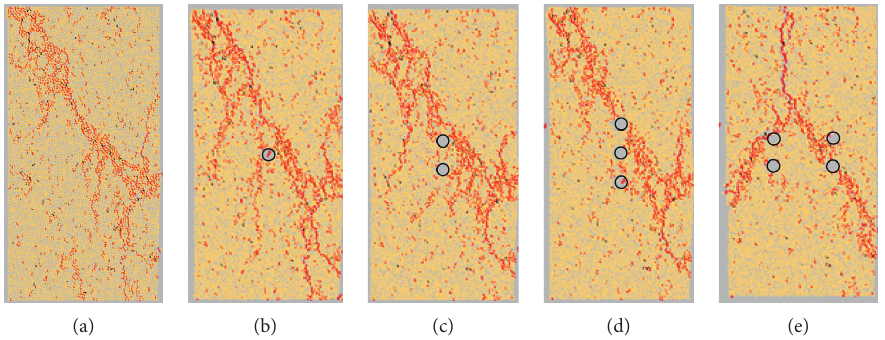
Figure 21: Macrofracture morphology of coal sample with different hole number. (a) Intercoal specimen, (b) N � 1, (c) N � 2, (d) N � 3, and (e) N �